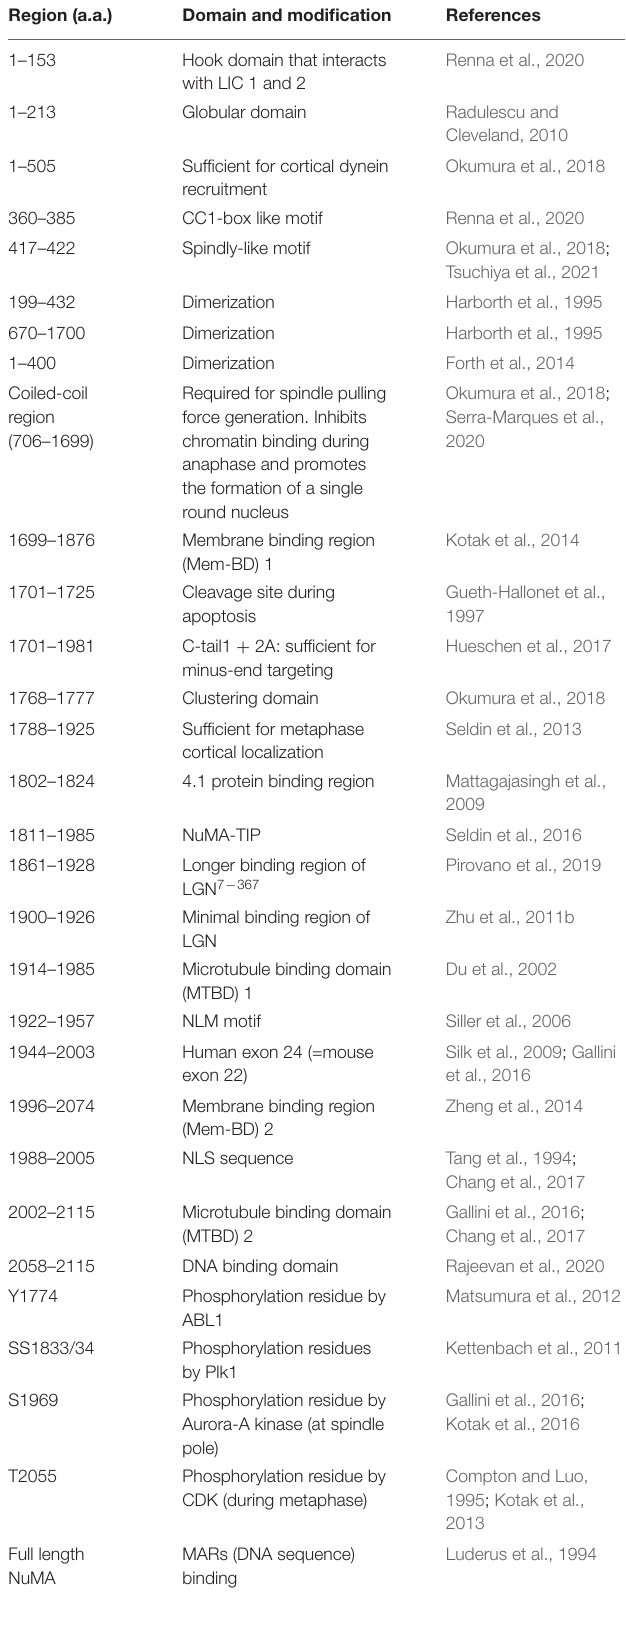
TABLE 1 | A summary of NuMA’s domain and modifications. Region